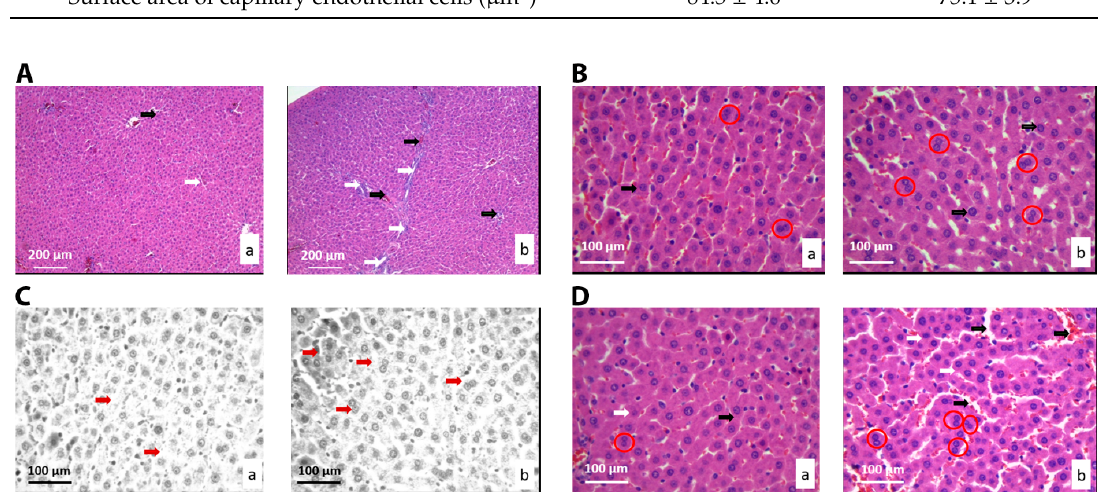
Figure 3. Micrographs of the histological cross-section of the liver of the control group ( a ) and treated group ( b ), (hematoxylin-eosin (H&E)). ( A ) White arrows show connective tissue and black show blood vessels. Magnification 20 × ; ( B ) Black arrows show hepatocytes’ nuclei, and red circles show hepatocytes with two nuclei. Magnification 50 × ; ( C ) Red scalpers show hepatocytes’ nuclei. Magnification 50 × , digitally processed RGB technique; ( D ) Black arrows show capillary sinusoids, and red circles show hepatocytes with two nuclei. Magnification 50 ×.